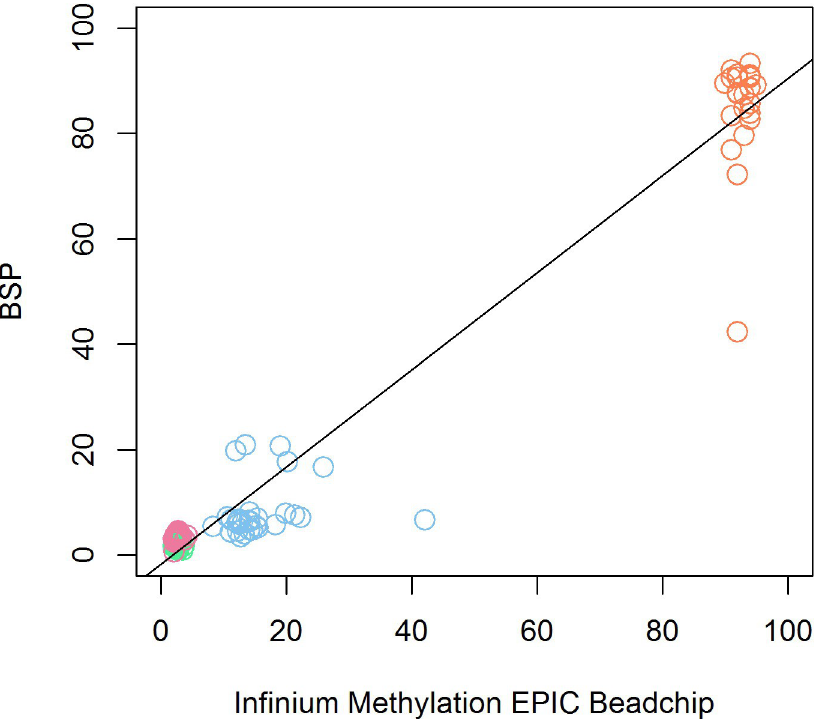
Fig 4. Scatter plot showing the relationship between the DNAm values of the four selected CpG sites quantified with the Infinium MethylationEPIC BeadChip (x-axis) and with bisulphite pyrosequencing (BSP) (y-axis). Dots colour code: Pink: cg02098128, green: cg17148978, blue: cg14120215, orange: cg19327414.